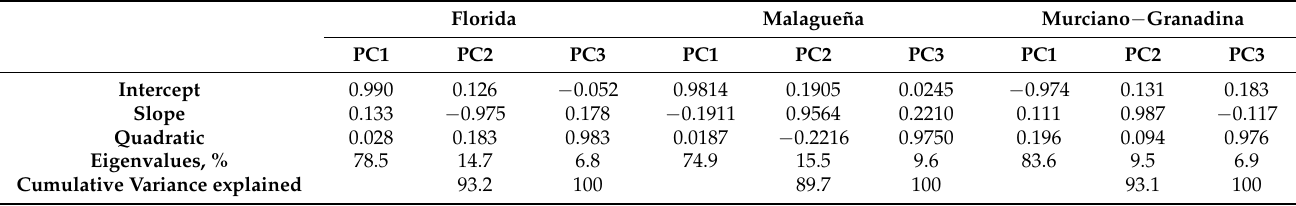
Table 3. Elements of the genetic random regression model 1; eigenvalues and eigenvector coefficients for the first three Principal Components (PC) from Ka matrix (Model 1) for daily fat protein yield in the three Spanish goat breeds